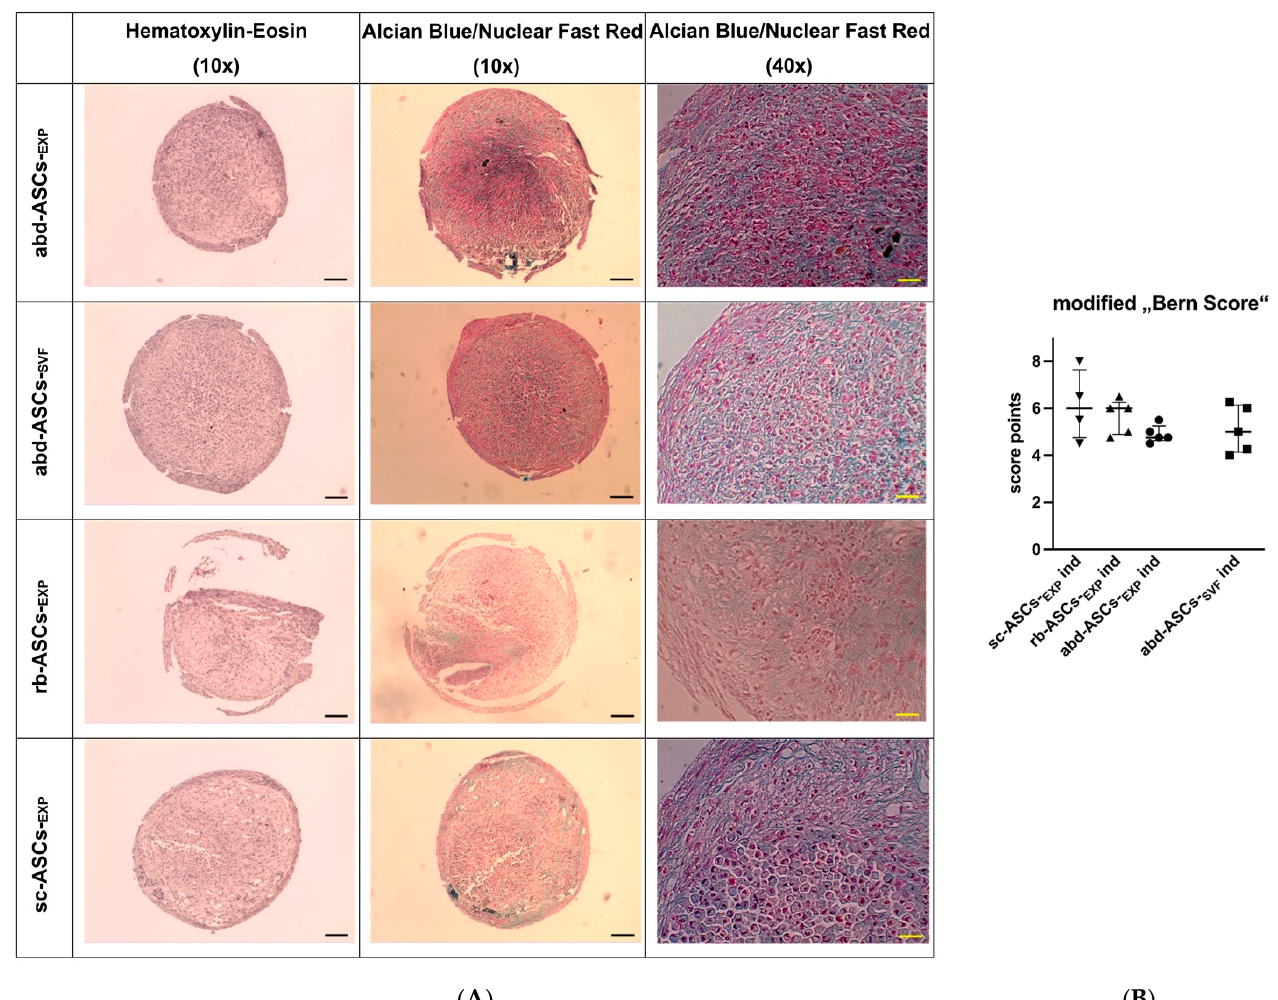
Figure 5. Chondrogenic differentiation. ( A ) Transmitted light microscopic images of chondrogenically induced adipose-derived stem cells (ASCs) of one representative horse. ASCs were generated from abdominal (abd), retrobulbar (rb) and subcutaneous (sc) adipose tissue using the explant method (EXP) or using the stroma vascular fraction (SVF) after collagenase digestion. Cells were subsequently stained with hematoxylin–eosin and Alcian Blue-Nuclear Fast Red to detect mucopolysaccharides on day 21. Scale bar (black): 100 µm (10× objective), scale bar (yellow): 25 µm (40× objective). ( B ) The chondrogenic differentiation potential of equine ASCs was assessed using the modified “Bern Score” according to [63]. Due to the small size of the cell pellets, the preparation of histological sections was not possible for all samples. The dot plot shows median values and interquartile ranges (error bars) ( n = 4 to 5).